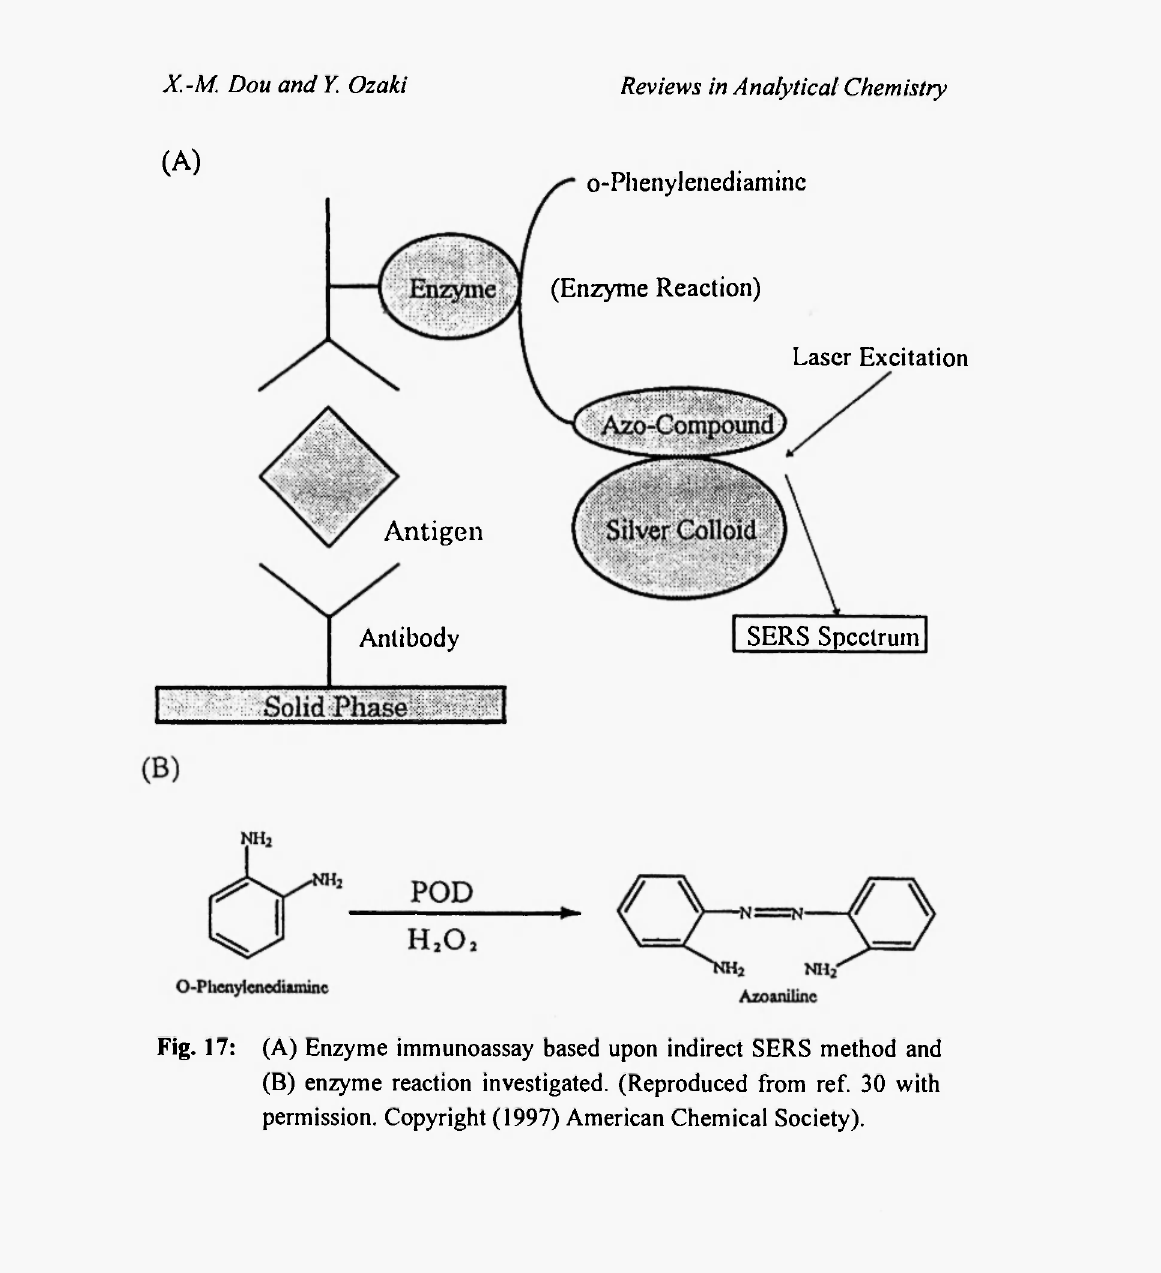
Fig. 17: (A) Enzyme immunoassay based upon indirect SERS method and (B) enzyme reaction investigated. (Reproduced from ref. 30 with permission. Copyright (1997) American Chemical